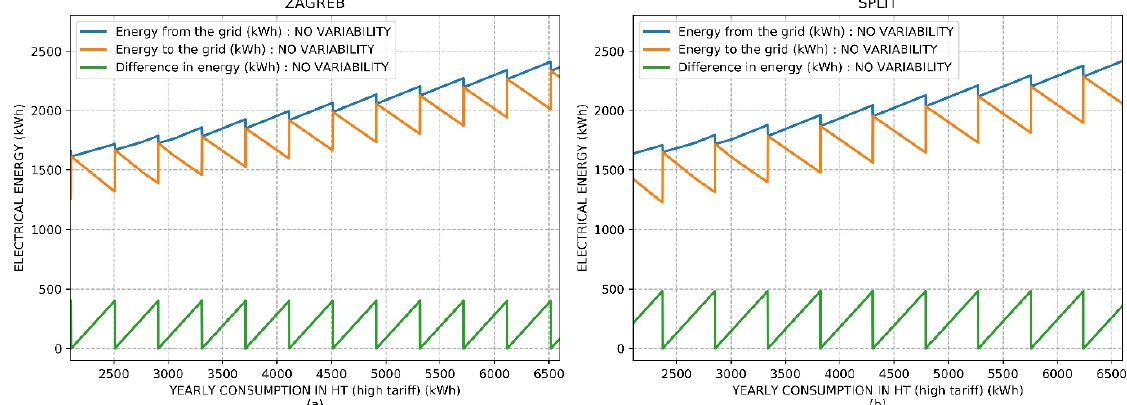
Figure 9. Simulation results for electricity balance between household and grid scenario without variability: ( a ) Simulation results for Zagreb. ( b ) Simulation results for Split.